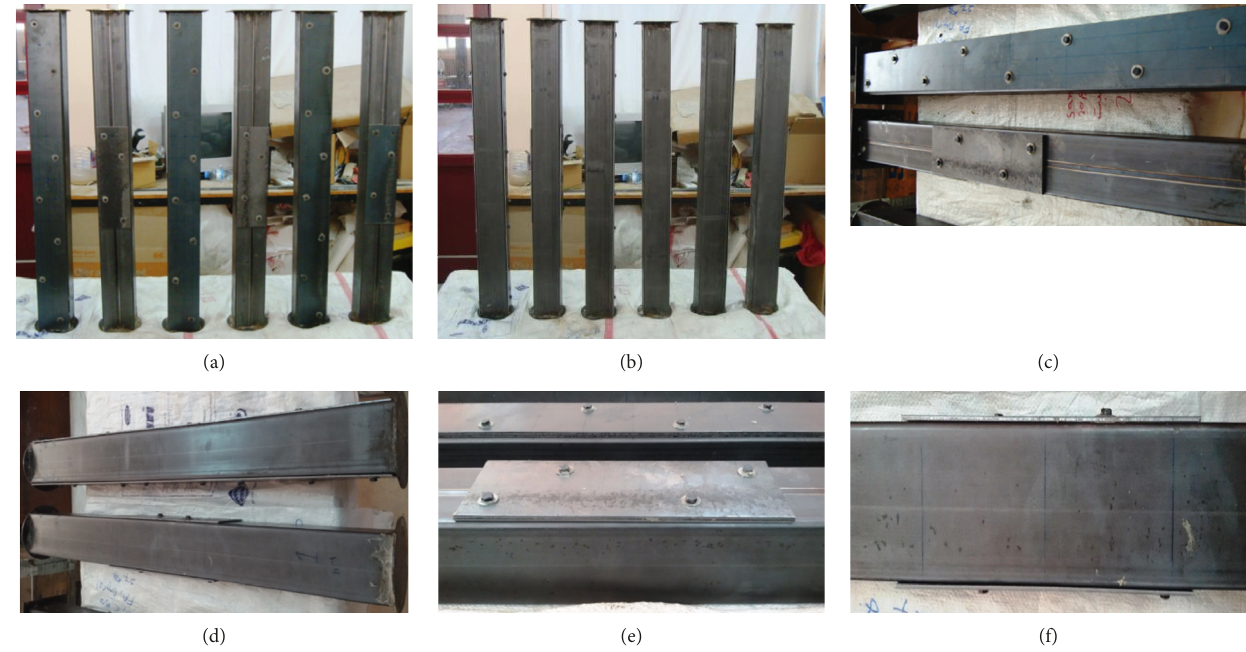
Figure 6: Retrofitting schemes of SCCFST beams. (a) Bottom flange view. (b) Side view. (c) Groups A and C retrofitting schemes. (d) Group B retrofitting scheme. (e) Double bottom steel plates. (f) Top and bottom steel plates.